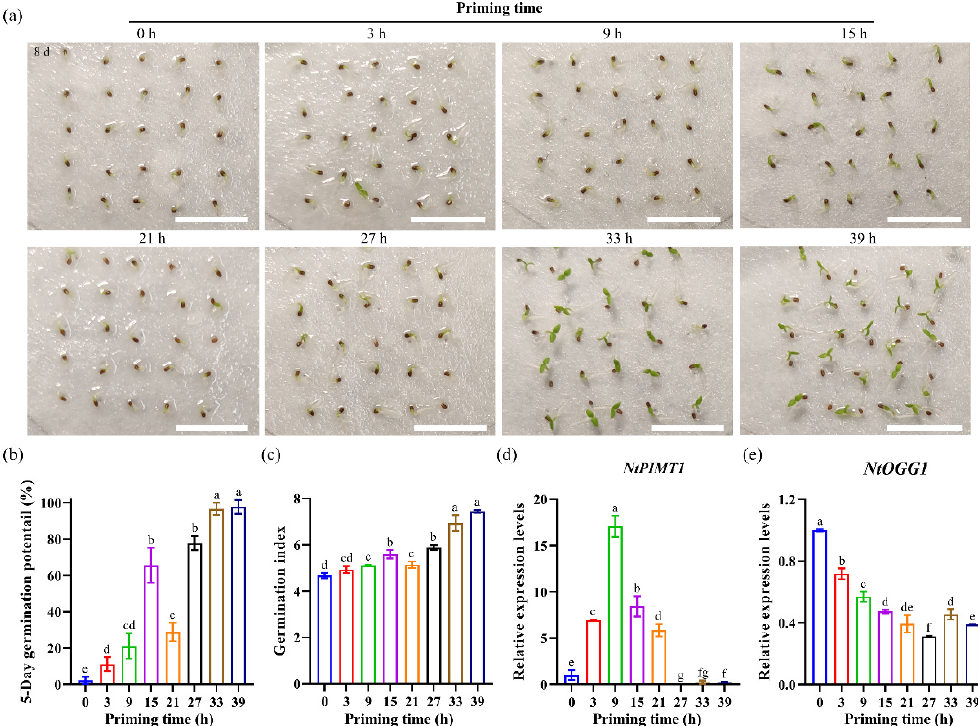
Figure 5. Characteristics of seed vigour and NtPIMT1 and NtOGG1 expression in non-pelleted seeds of tobacco cultivar ‘Yunyan 87 ′ after priming treatments. ( a ) Representative images of germination at 8 d under 15 °C conditions after 0 (CK), 3, 9, 15, 21, 27, 33, and 39 h GA 3 priming treatments. Scale bars = 10 mm. ( b ) Germination potential; ( c ) germination index. Expression pattern of ( d ) NtPIMT1 and ( e ) NtOGG1 in priming seeds. Data are means (±SD), n = 3. Different letters above the column indicate significant differences determined using ANOVA test: p < 0.01.